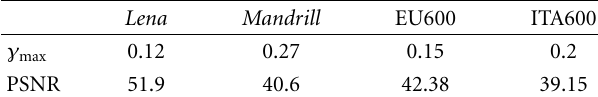
Table 1: Maximum watermark strength, γ max ,subject to watermark invisibilityandcorrespondingPSNR (dB)obtainedfor4testimages with the DFT-domain watermarking algorithm described in [7, 8].